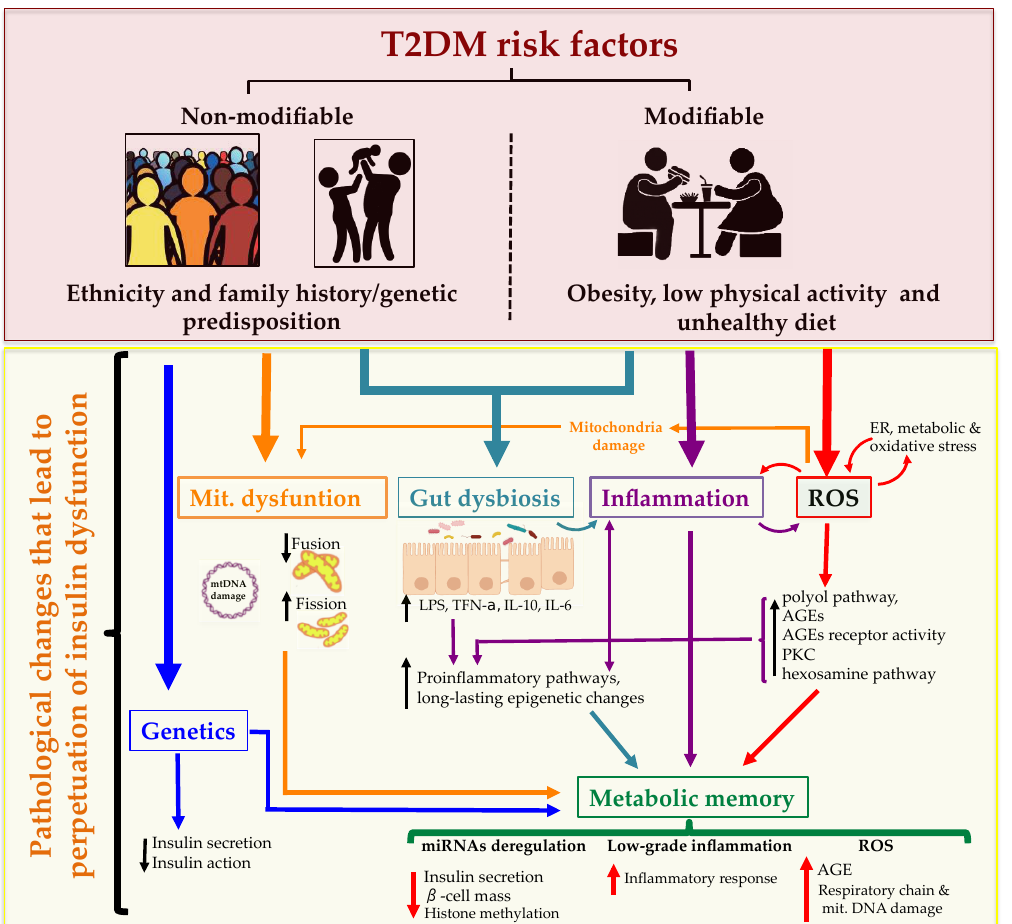
Figure 2. Type 2 Diabetes Mellitus (T2DM) risk factors and the pathological changes leading to the perpetuation of insulin dysfunction. Complex combinations of genetic, metabolic and environmental factors that interact with one another constitute both non-modifiable (ethnicity and family history/genetic predisposition) and modifiable risk factors (obesity, low physical activity and an unhealthy diet). These states affect cell function resulting in a complex network of pathological changes that influence mutually and lead to the perpetuation of insulin dysfunction. ROS: reactive oxygen species; ER: endoplasmic reticulum; AGEs: advanced glycation end products; PKC: protein kinase C; LPS: lipopolysaccharide; miRNA: microRNA.